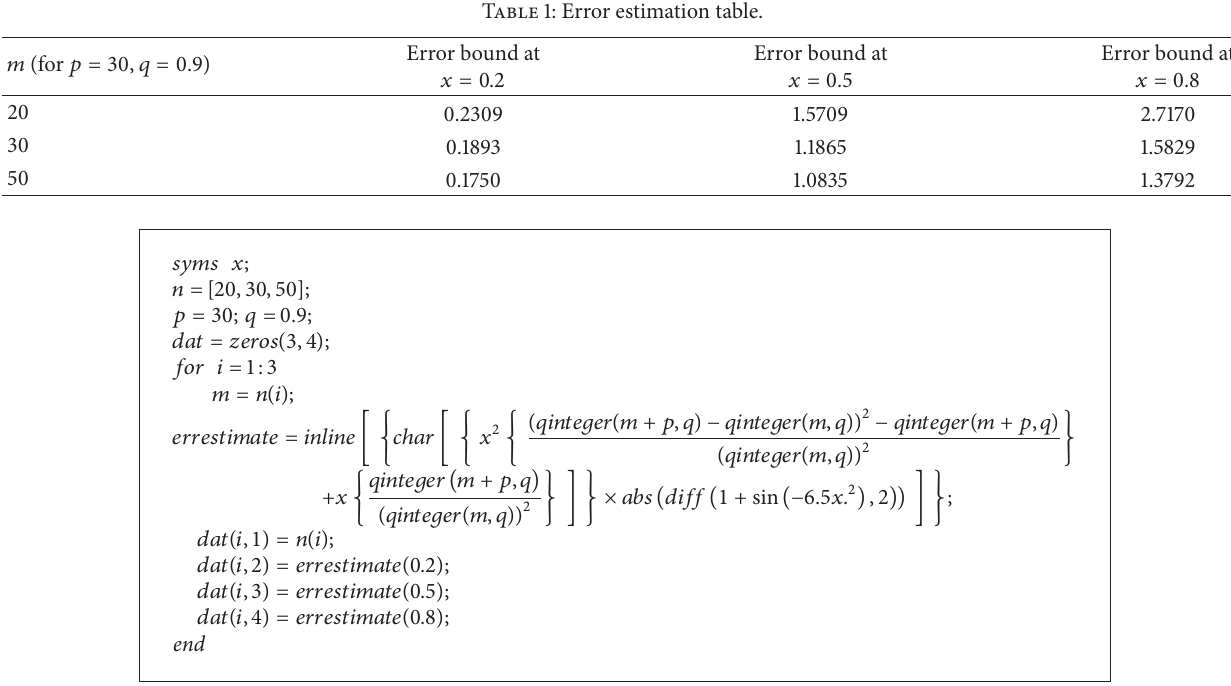
Algorithm 1: Error estimate